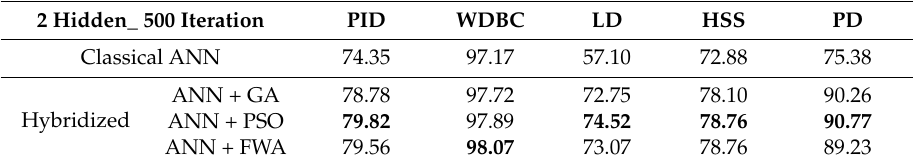
Table 2. Two-hidden-layer ANN hybridized with optimization algorithms GA, PSO, and FWA for